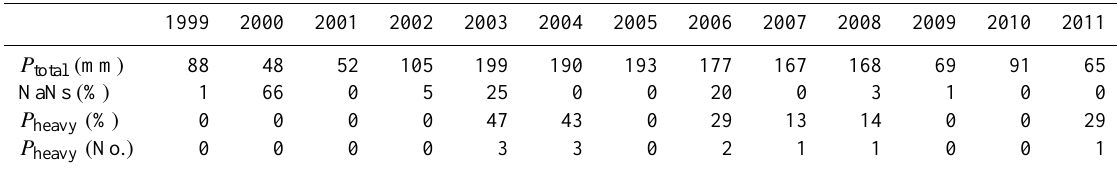
Table 4. Analysis of annual rainfall records for Samoylov Island. P total : total annual rainfall in mm; NaNs: percentage of missing values, May to end of September; P heavy (%): rainfall events that exceeded 16mm (the threshold of 16mm is exceeded by only 1% of all rainfall events); P heavy (No.): number of rainfall events that exceeded 16mm. Note that the years 2000, 2003 and 2006 had missing data between 20 to